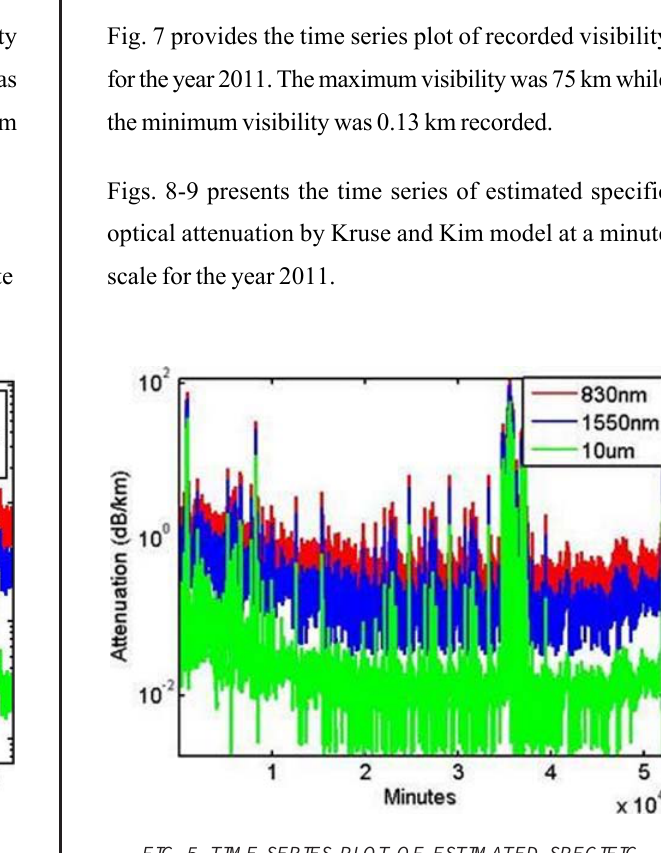
FIG. 5. TIME SERIES PLOT OF ESTIMATED SPECIFIC OPTICAL ATTENUATION BY KRUSE MODEL FOR THE YEAR